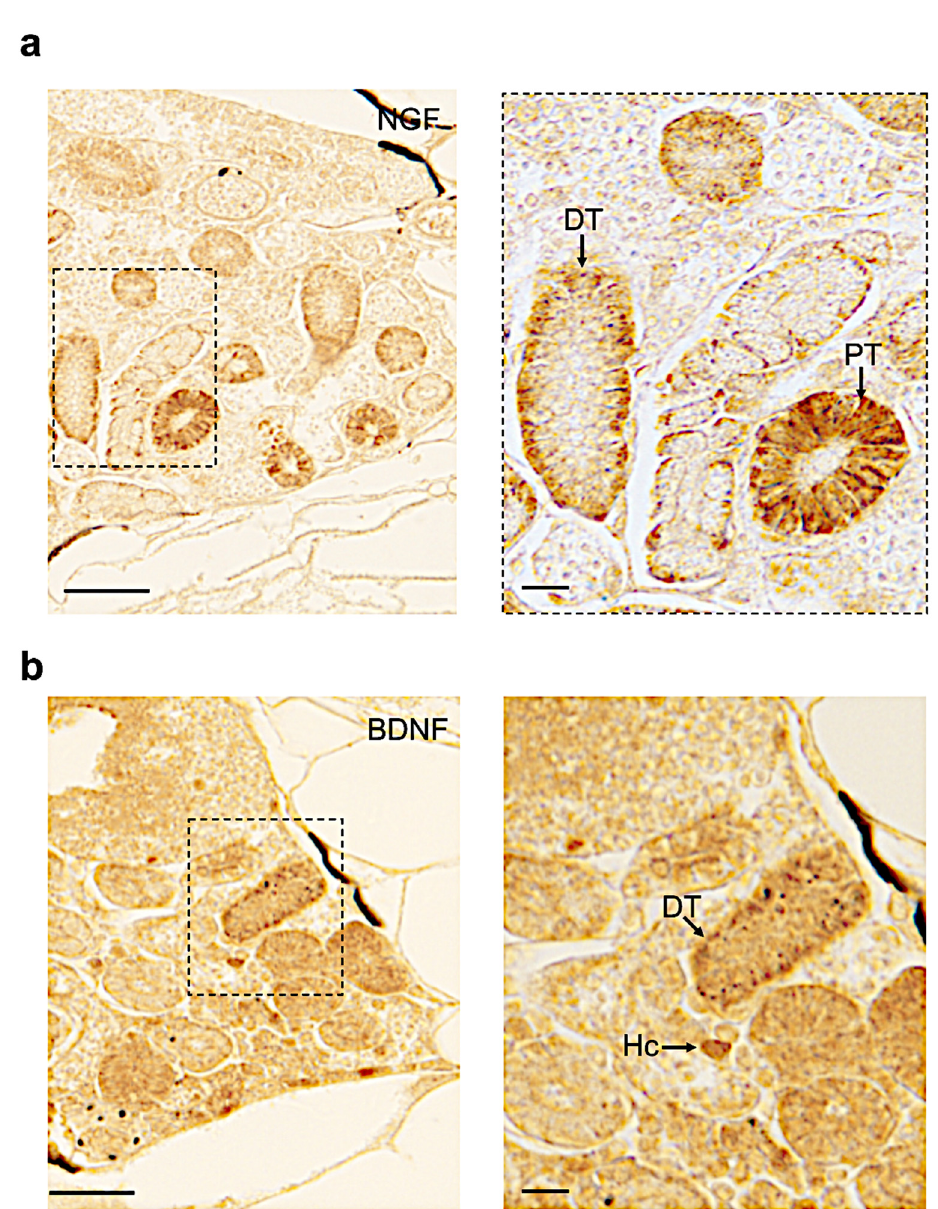
Figure 6. Immunohistochemistry to detect NGF and BDNF on paraffin sections of adult zebrafish kidney. ( a ) NGF protein in adult zebrafish kidney is detected in distal and proximal tubules (respec- tively, DT and PT). ( b ) BDNF protein is distributed in distal tubules and a few hematopoietic cells (DT and Hc). Scale bars: 200 µ m and 50 µ m ( a , b